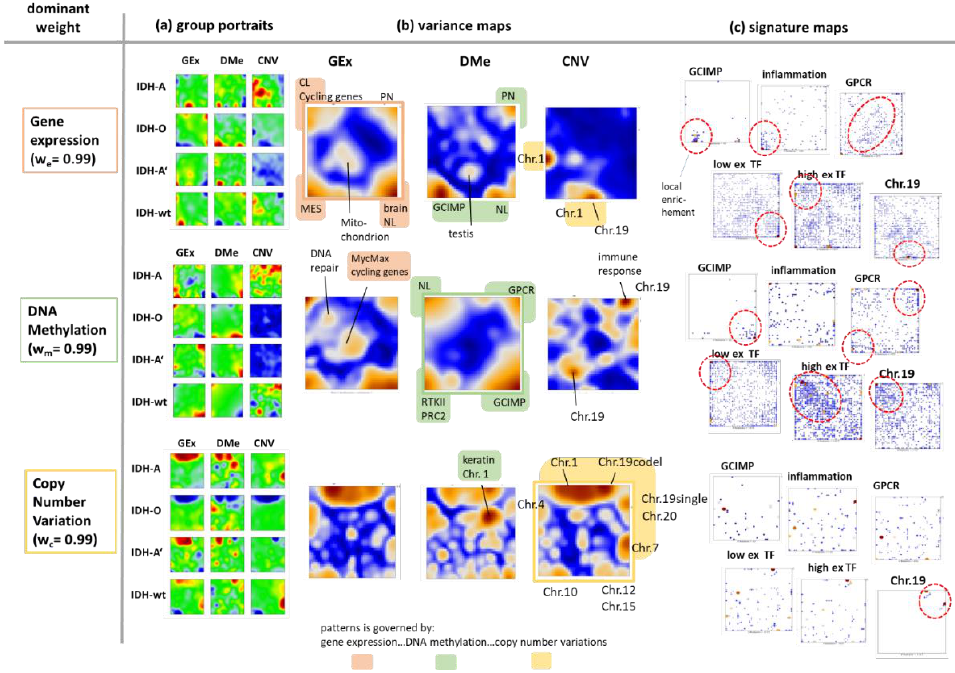
Figure A4. CombiSOM of LGG using dominant weights (w = 0.99) for gene expression, DNA meth- ylation and CNV, respectively. The mean portraits of the genetic groups in the Gex, Dme and CNV domains and the variance maps reflect different topologies of the SOM which are governed by the respective “dominantly weighted” omics domain. They result in different distributions of genes across the maps. (compare with Figure 4a, c referring to the equally weighted combiSOM). ( a ) The mean group portraits enable to identify modules of co-regulated genes of high feature (Gex, Dme, CNV) values in the different genetic groups. ( b ) The variance maps identify spot-regions of co-ex- pressed (Gex map), co-methylated (Dme) and co-aberrant (CNV) genes which partly mutually over- lap between the different modalities. ( c ) Distribution of genes in each of the SOM is different. It is governed by the dominantly weighted omics domain giving rise to clusters of highly variant gene expression (Gex), methylation (Dme) or copy numbers. Selected gene signatures consequently dis- tribute differently in the different SOM. GCIMP genes were collected by combined hypermethyla- tion and underexpression [37]. They consequently accumulate in certain areas in the Gex and Dme- dominated maps but diffusely spread over different chromosomal locations in the CNV dominated map. Inflammatory genes [44] show the strongest local enrichment in the Gex dominated SOM but are more distributed in the two other SOM. Genes encoding G-protein coupled receptors (GPCR) accumulate in the middle of the Gex dominated SOM, an area of low variant expression, while in the Dme-dominated SOM these genes associate with higher variance, meaning that to a higher de- gree with changing methylation than with expression. Low expression transcription factor genes associate more with epigenetic modes of genomics regulation, while high expression TF associate more with transcription factor networks [56].